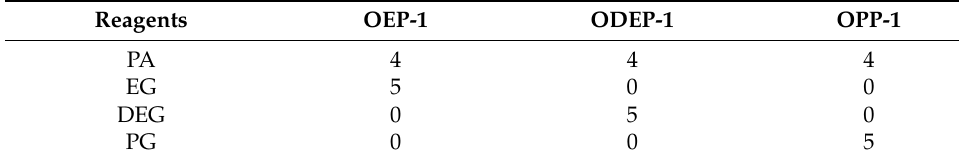
Table 1. Molar ratios of OEP-1, ODEP-1, and OPP-1 samples synthesis